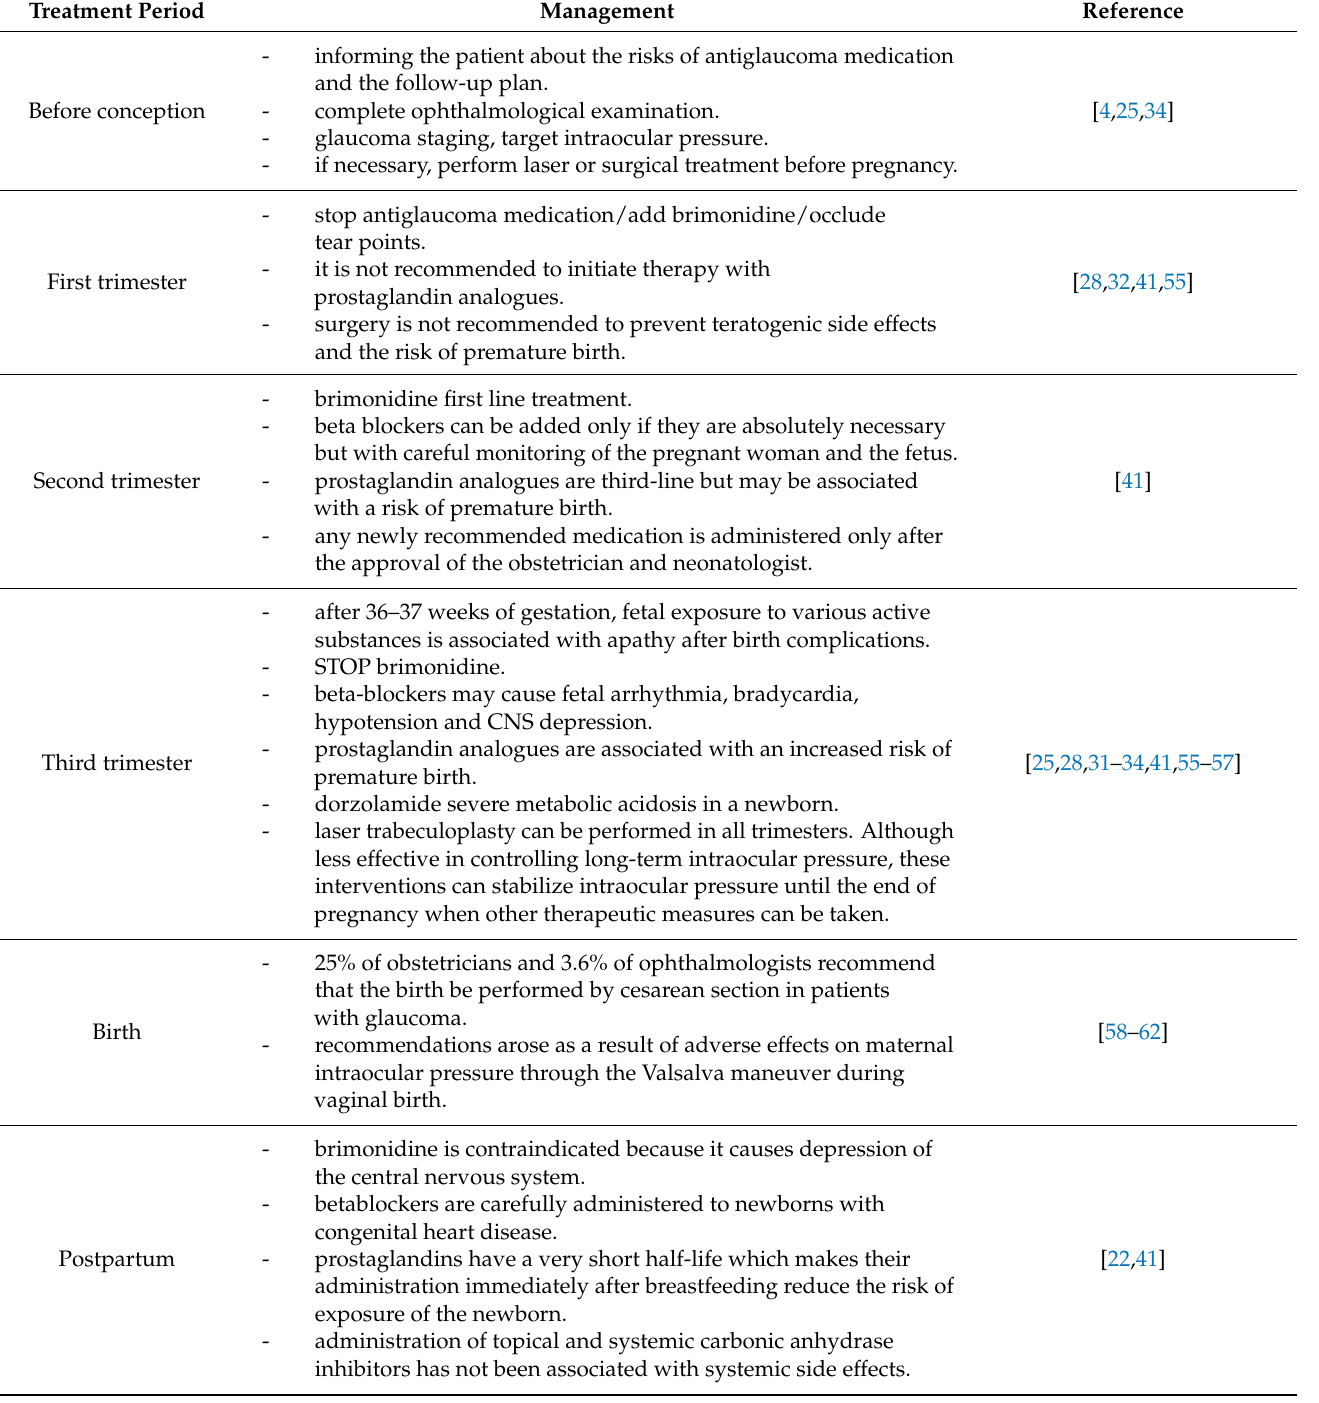
Table 6. The type of drugs they can administer and related